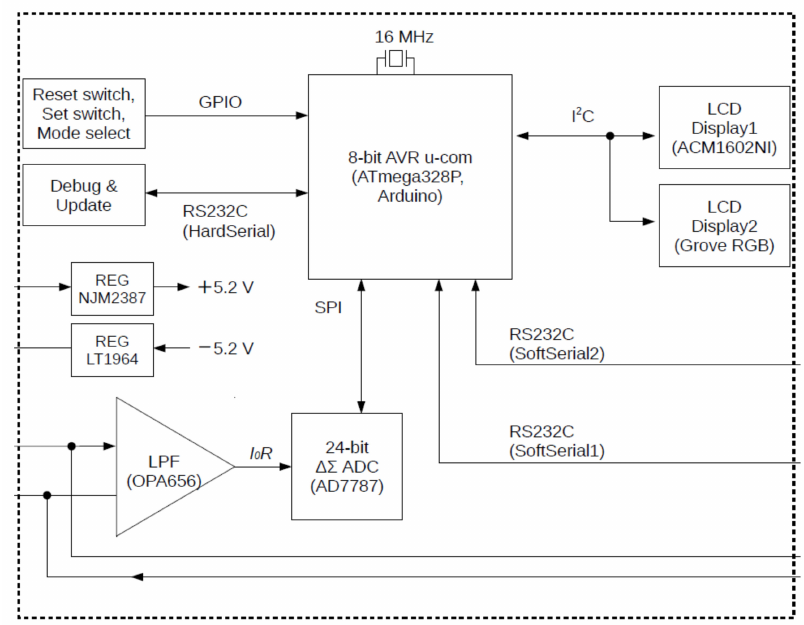
Figure 2. A block diagram showing the proposed design on our microcomputer-based system. The list of abbreviations is as follows: LCD: liquid crystal display, APD: avalanche photodiode, AMP: amplifier, LPF: low-pass filter, VNDF: variable neutral density filter, REG: voltage regulator, and ADC: analog–digital converter. Nomenclatures of ATmega328P (RISC (reduced instruction set computer) controller), APD440A2, OPA656, and AD7787 are the product